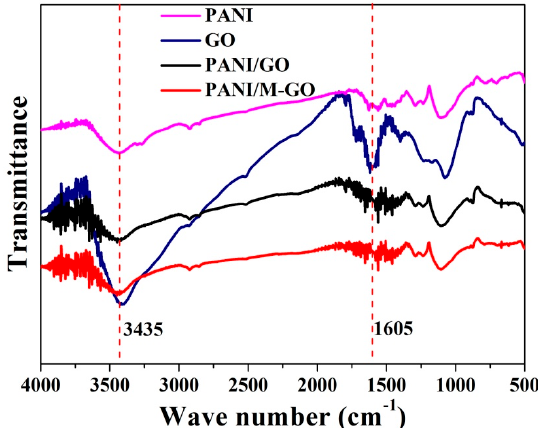
Figure 8. Fourier-transformed infrared spectroscopy (FT-IR) spectra of PANI, GO, PANI/GO, and PANI/M-GO composites.